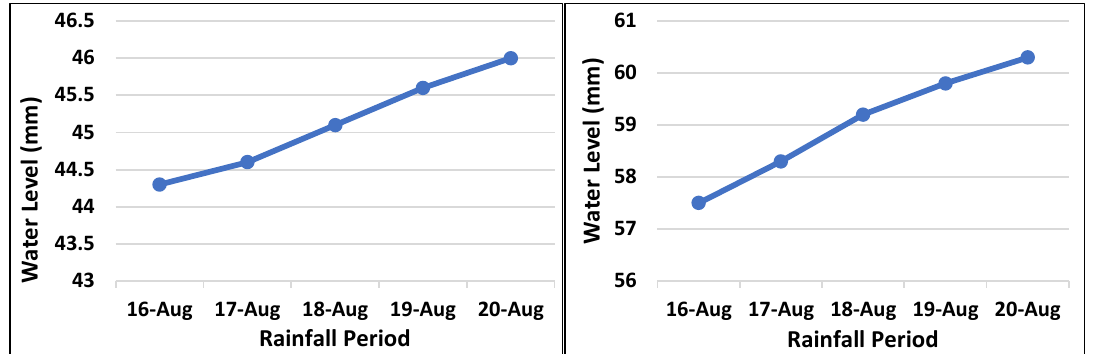
Figure A5. Water level (mm) recorded at Ahirwalia and Samastipur gauge stations of CWC during 16–20th August,